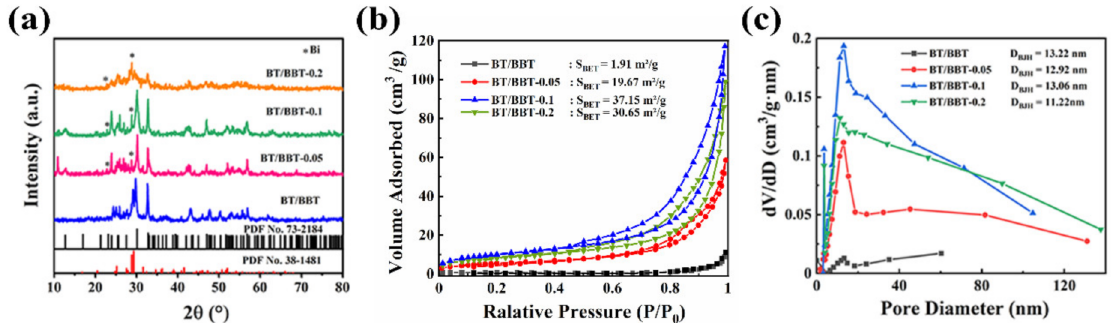
Figure 2. ( a ) XRD patterns, ( b ) nitrogen adsorption-desorption isotherms, ( c ) pore size distribution curves of BT/BBT, BT/BBT-0.05, BT/BBT-0.1, and BT/BBT-0.2